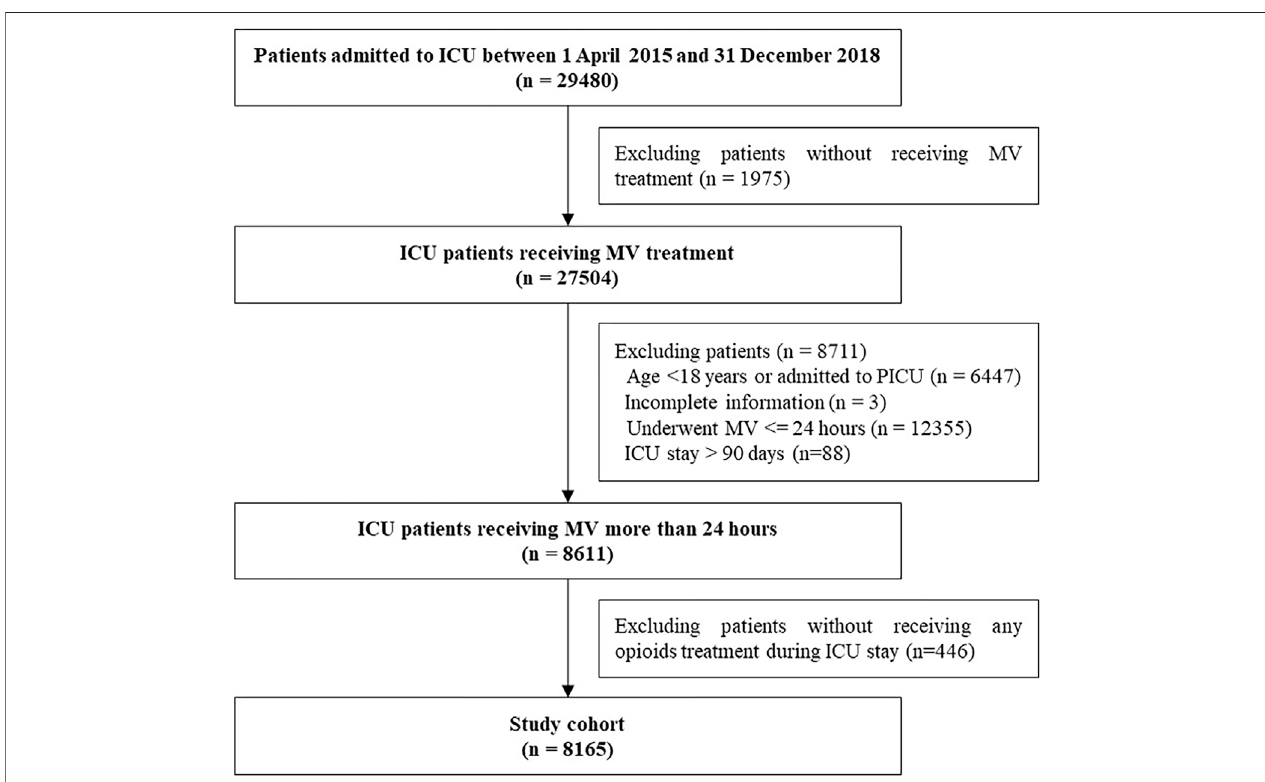
FIGURE 1 | Study fl ow